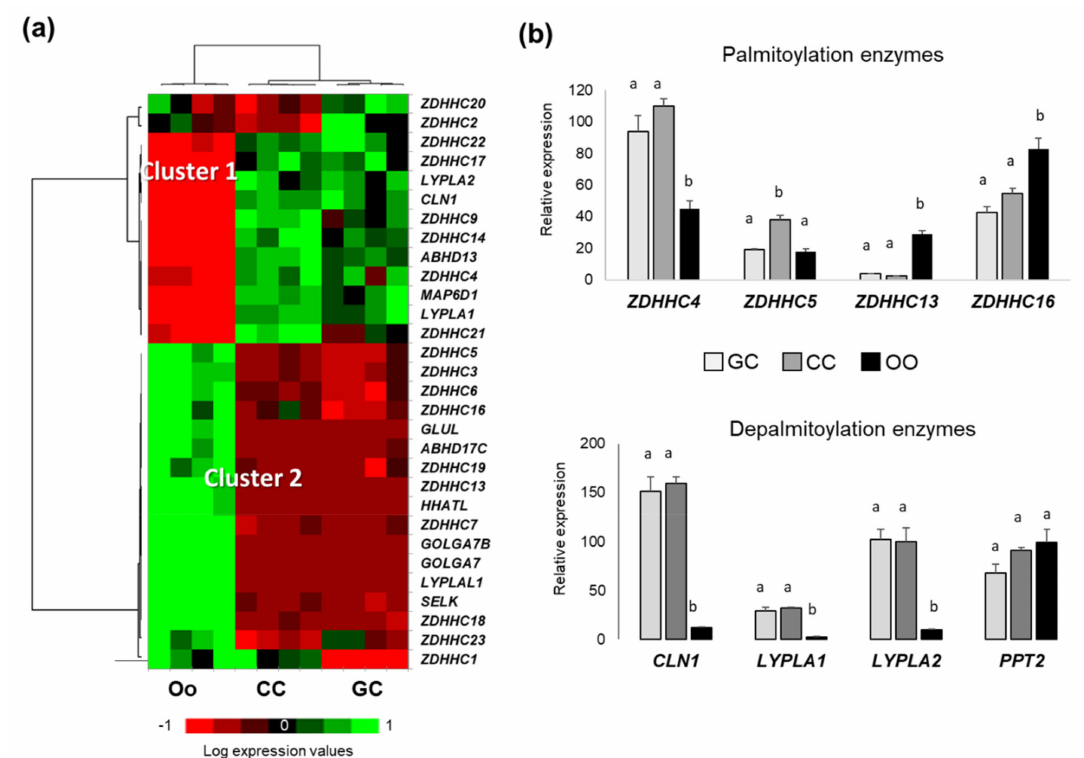
Figure 6. Expression patterns of the genes involved in protein palmitoylation detected by microarray hybridization. ( a ) Heat map representation of differential expression of the genes coding palmitoylation and depalmitoylating enzymes in granulosa cells (GC), cumulus cells (CC) and oocyte (OO) ( n = 4 per each cell type). ( b ) Gene expression of the most abundant parmitoyl-transferases and acyl-thioesterases. Bars are mean values of four independent samples ± SEM. Different letters signify significant differences at p <